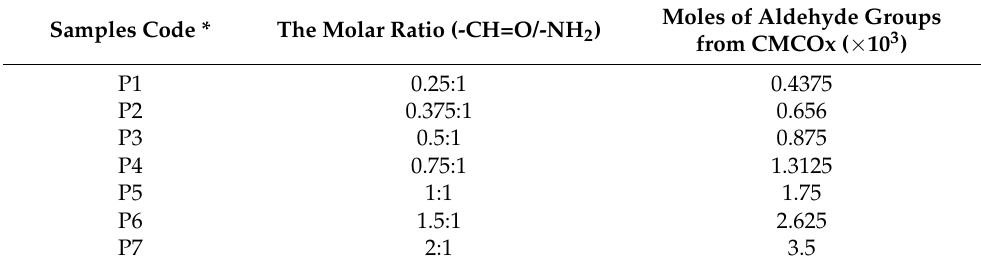
Table 3. The experimental program used to obtain covalently cross-linked hydrogel films based on CS and